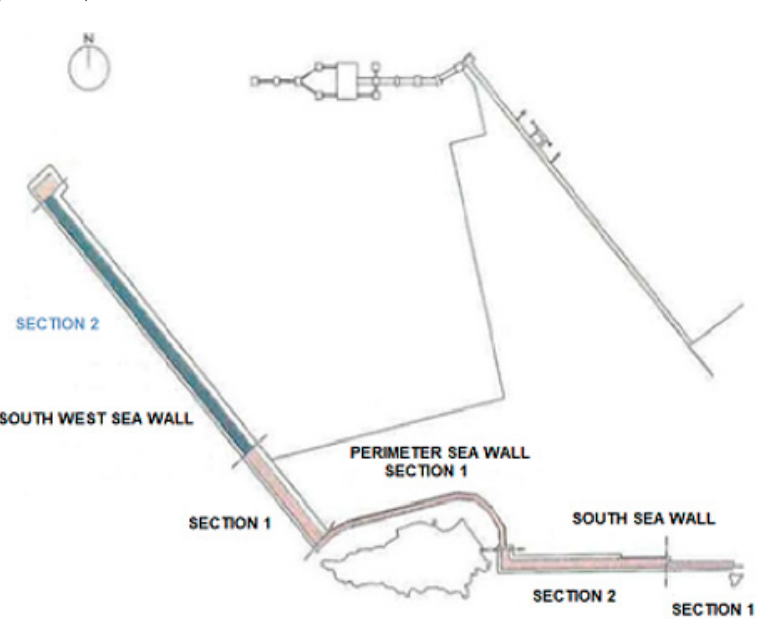
Figure 3. General Figure 3. General drawing.